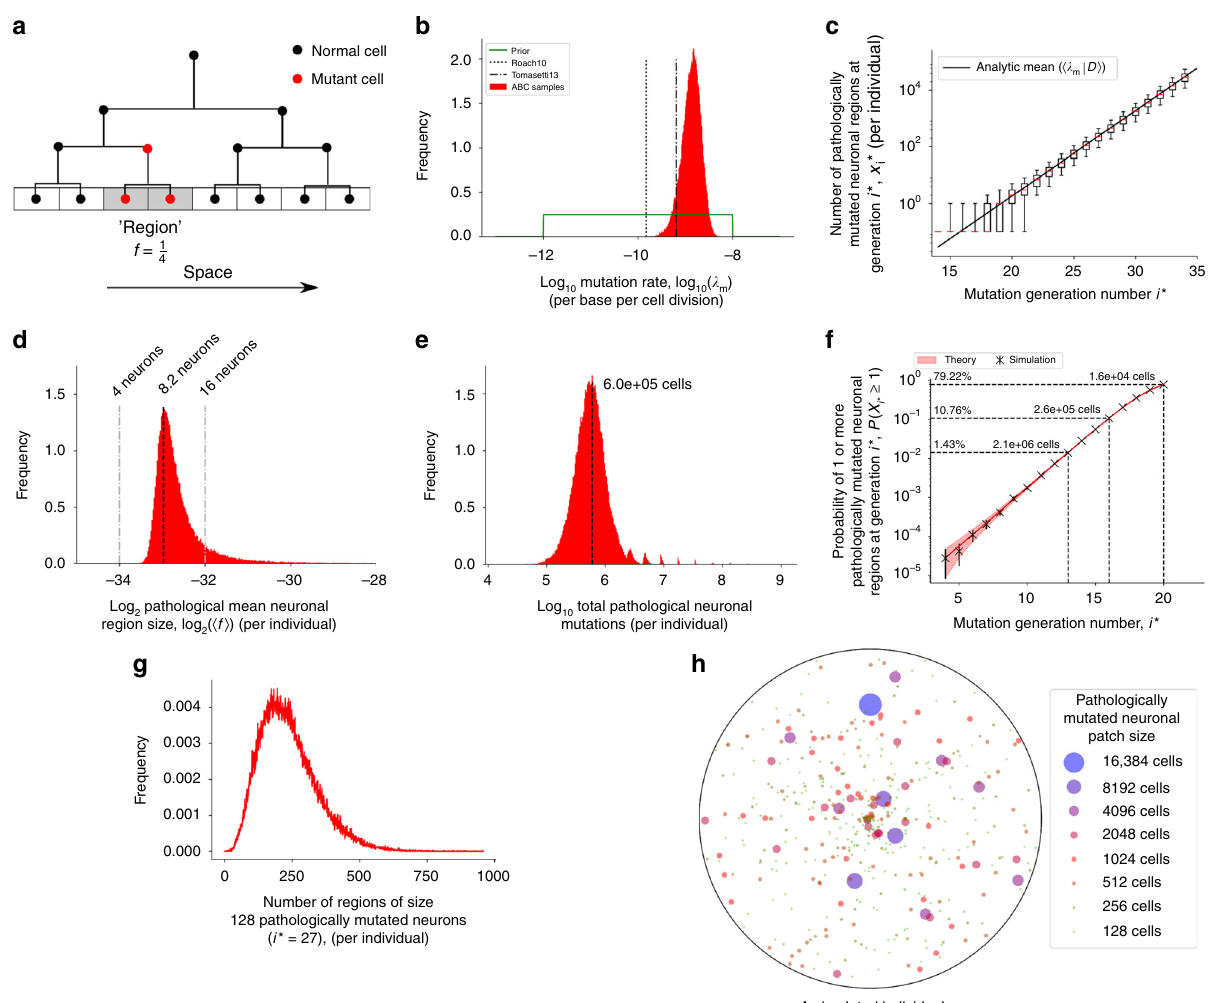
Fig. 5 Estimates for the prevalence of somatic mutations. a Model of mutagenesis during brain development (Supplementary Methods; Supplementary Fig. 7). Red circle = cell containing a somatic mutation, black circle = cell with the wild-type allele. Development is modelled as a simple branching process. Every base was assumed to have a constant probability of mutation during replication. When a mutation arises in the lineage, its mutant daughters occupy a fraction f of the adult brain, termed a ‘ region ’ . b Prior (green solid) and approximate posterior (red bars) for the mutation rate using approximate Bayesian computation, with literature values (black lines). c – f Using the approximate posterior samples for λ we simulated brain development of the neuronal m subpopulation (see Supplementary Methods). c Distribution of the number of mutated regions per individual, for each generation number ( i * ), in any of the case genes associated with pathology. Boxplot whiskers show the 5th and 95th percentiles, median shown in red (when an individual has 0 mutations at generation i * , the number of mutations is assigned to be 0.1, for representation on a log-scale). Showing the analytic mean of Eq. (16) in Supplementary Methods, where λ is the approximate posterior mean (black solid line). d Distribution of the pathological mean relative region size across individuals. m e Distribution of total number of pathological mutations across individuals. Multimodality is induced by the largest pathological region (Supplementary Fig. 7). f Fraction of simulated human individuals with at least 1 pathologically mutated region seeded at generation i * . Comparison to theory shown in red, mean de fi ned in Eq. (20) and standard deviation Eq. (21). (Error bars are a Bernoulli error model). g Frequency distribution over individuals of pathologically mutated regions of size 128 neurons. h Representation of the size and frequency distribution of pathologically mutated regions (seeded between 20 ≤ i * ≤ 27) in an individual human brain. Whole brain area (black circle) is not to scale with the mutated regions (coloured circles). Data used in the model inference was derived from neurodegenerative patients — but no signi fi cant difference in mutation prevalence of case genes between control and case patients were